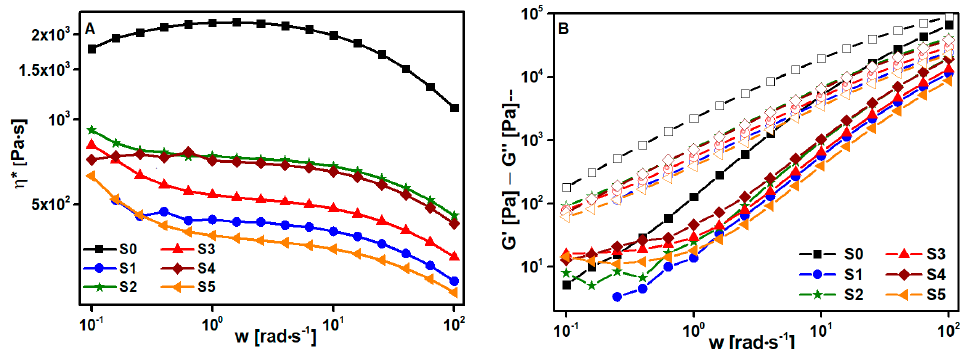
Figure 2. ( A ) Complex viscosity ( η *) and ( B ) crossing points of the solvent optimization study, in which the closed marks are G ′ and the open ones are G ″ .